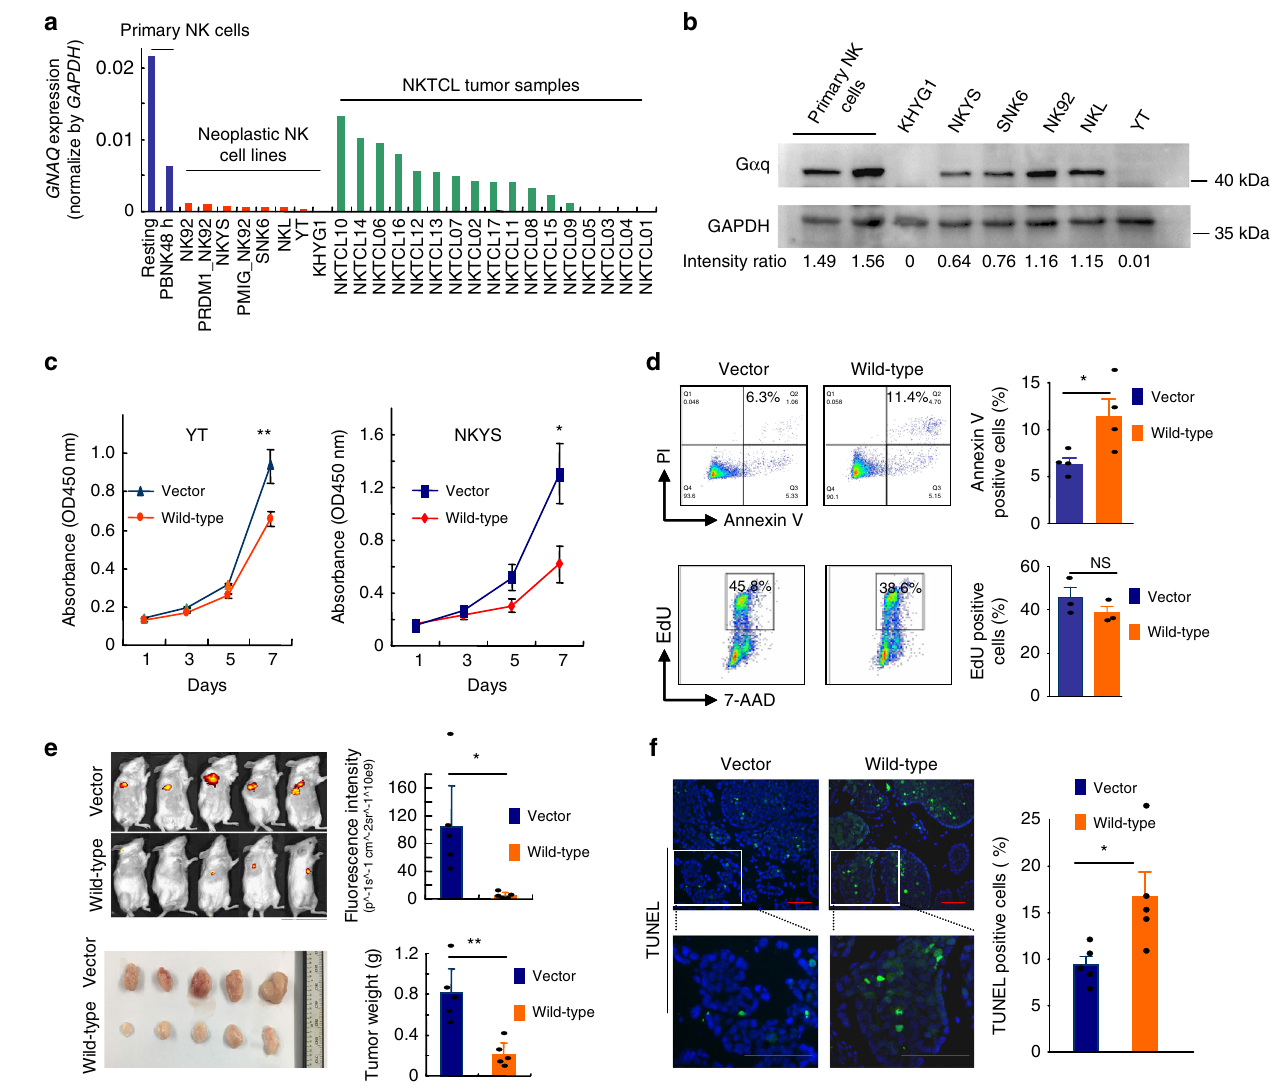
Fig. 4 Tumor-suppressive role of G α q in NKTCL. a GNAQ mRNA expression in normal NK cells, neoplastic NK cells, and tumor samples. The GNAQ expression values were obtained from previously published data and our RNA sequencing data and normalized to GAPDH . Resting NK: >95% CD56 + CD3 − NK cells isolated from peripheral blood lymphocytes. PBNK48h: 48-h IL-2-activated NK cells. PMIG_NK92 and PRDM1_NK92: NK92 cells transduced with PMIG and PRDM1, respectively. b GNAQ protein expression in normal and neoplastic NK cells. c Forced expression of G α q suppressed cell viability in YT (left) and NKYS (right) cells. YT and NKYS cells were stably transfected with vector control or wild-type GNAQ , and cell viability was assessed using a CCK-8 assay. Cell viability is presented by the absorbance value at OD 450 nm, which was measured with a Multiskan FC microplate reader (Thermo Scienti fi c, Waltham, MA, USA). The value is directly proportional to the number of viable cells in the culture medium. Data are representative of three independent experiments. d Overexpression of G α q signi fi cantly enhanced cell apoptosis but had little effect on NK cell proliferation. Cell apoptosis and cell proliferation were assessed by Annexin V staining (upper panel) and EdU incorporation assay (lower panel), respectively. Data are representative of at least three independent experiments. e NOD/SCID mice were inoculated subcutaneously with YT cells stably transfected with vector control or wild-type G α q ( n = 5 in each group). The tumor burden was monitored by utilizing the IVIS Spectrum system (Perkin Elmer, Beacons fi eld, UK) after 6 weeks. Representative images and quantitative data for each group are shown in the upper panel. Representative images of xenograft tumors and tumor weights for each group are shown in the lower panel. f Representative images (left) and quantitative data (right) ( n = 5 in each group) for TUNEL staining of the xenograft tumor tissues. Scale bars, 50 μ m. All data are expressed as the mean ± s.e.m.; NS, not signi fi cant. * P < 0.05, ** P < 0.01, *** P < 0.001, unpaired two-tailed Student ’ s t -test. Source data are provided as a Source Data fi